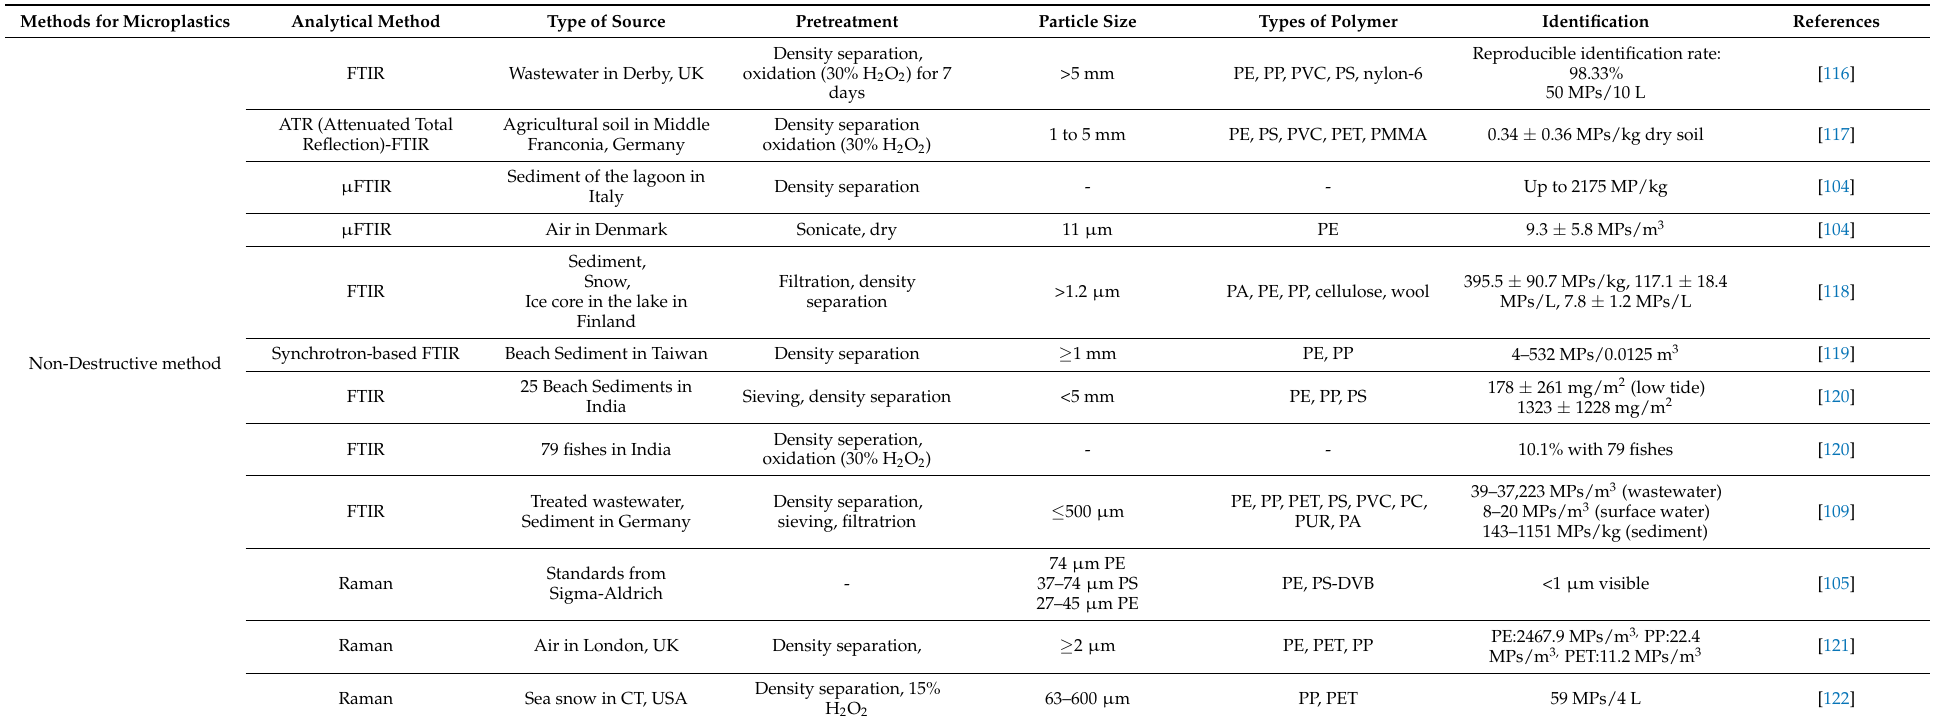
Table 3. Non-destructive analytical method for microplastic